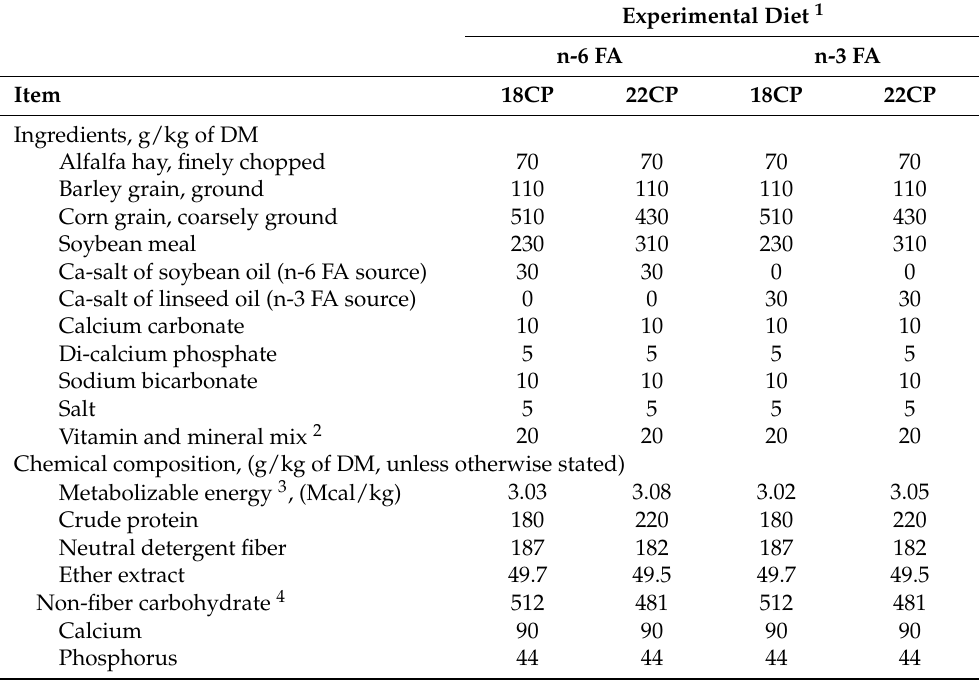
Table 1. Experimental starter diets ingredients and chemical composition (g/kg of DM, unless otherwise